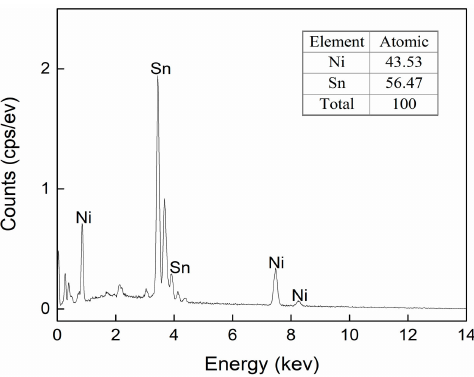
Figure 8. EDS analysis for the exposed IMCs at the bottom of dimples marked as C in Figure 7c.